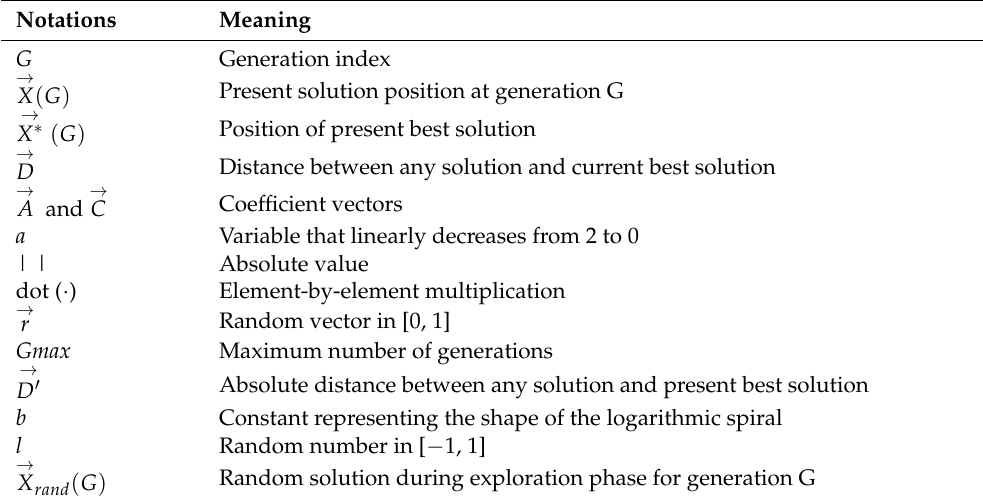
Table 4. WOA notations and